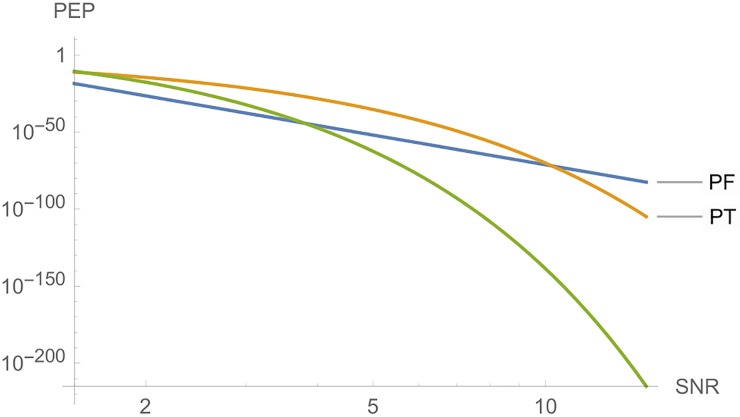
Graphs of PF, PT and PE for Example 8, where nT = nR = l = 8, and SNR is a function of Es.